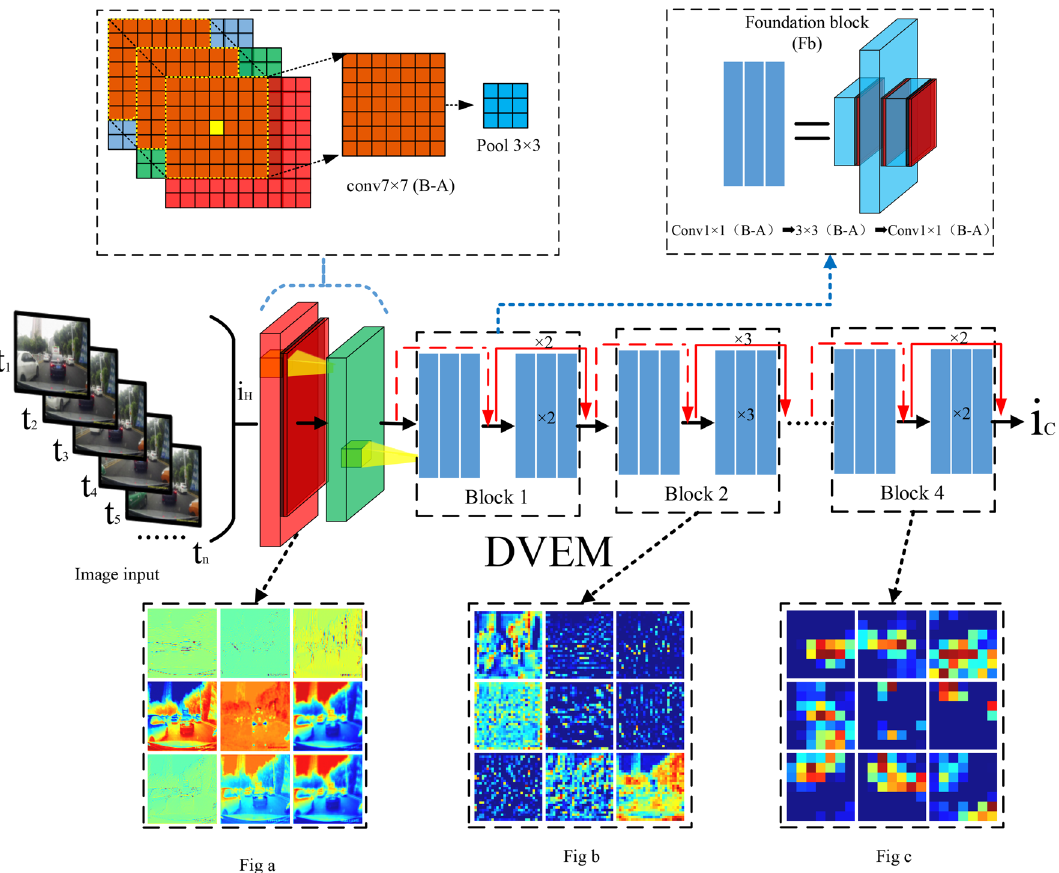
Figure 3. The structure of the driver field of vision information extraction module